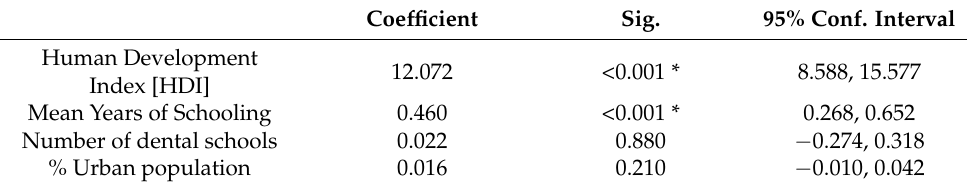
Table 2. Unadjusted linear regression analysis of combined OHWF per 10,000 population in the AFR, 2019.